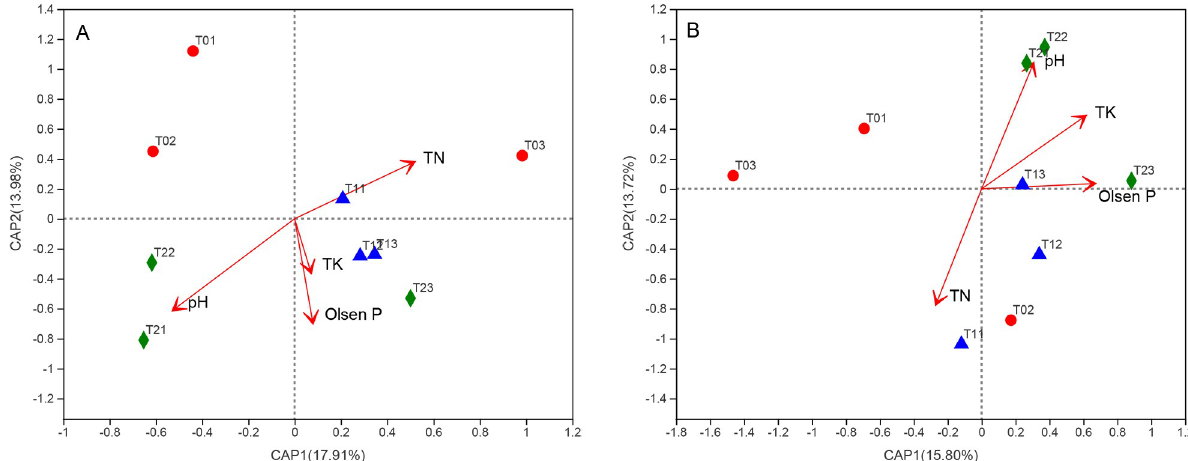
Fig 7. Distance-based redundancy analysis (db-RDA) of the bacterial (A) and fungal (B) communities based on environmental factors. Notes: T0 = Traditional irrigation; T1 = Traditional irrigation and fertilization practice; T2 = Water-saving irrigation and optimizing fertilization. N: Nitrogen; TN: Total N; P: Phosphorus; K: Potassium; TK: Total K.